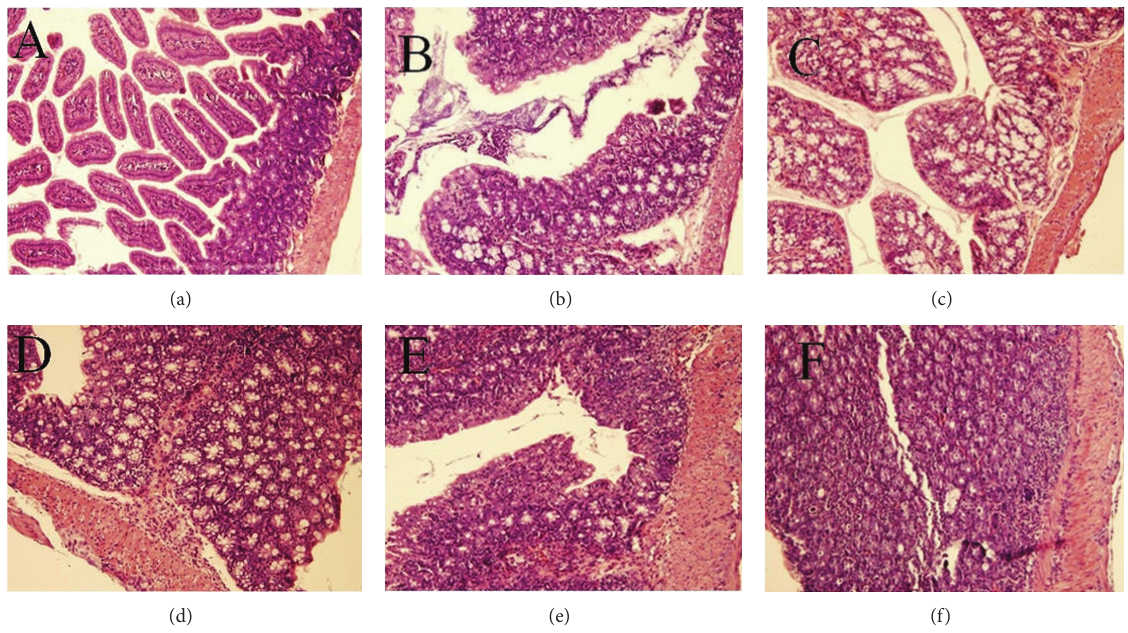
Figure 2: Histological findings of IL-10KO and WT mice by H&E staining ( × 200). Colonic sections of WT mice (a), IL-10 treatment mice at 14 (b) and 16 (c) wk of age and IL-10KO mice at 12 (d), 14 (e), and 16 (f) wk were stained with H&E staining.